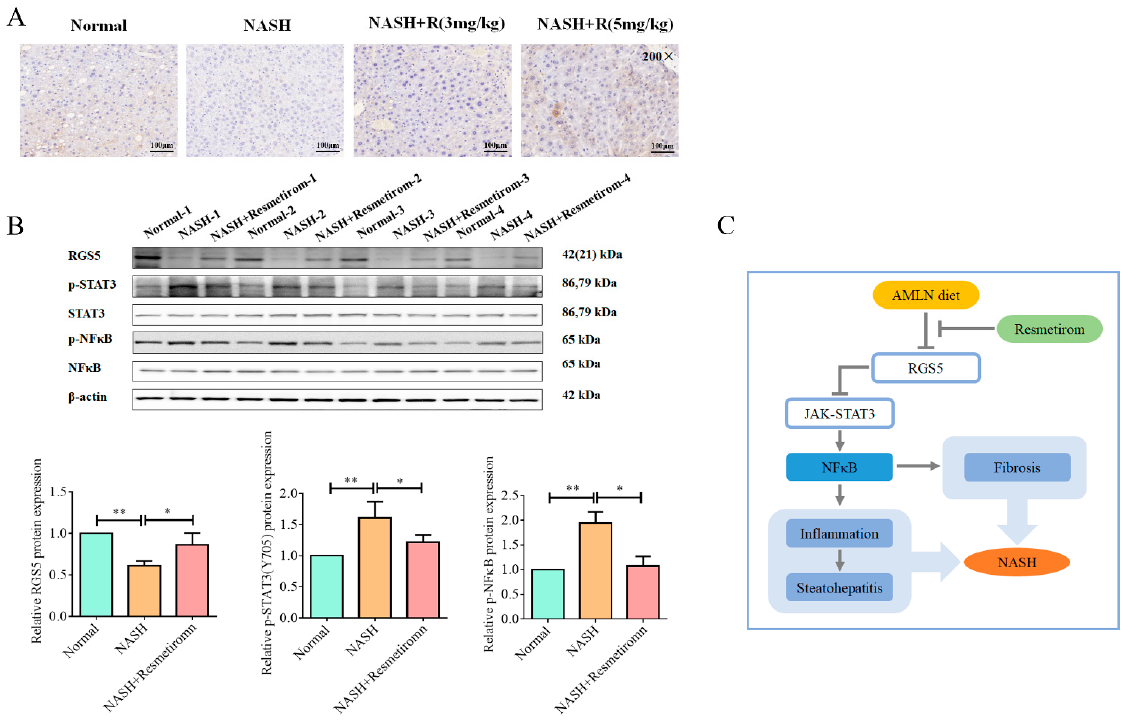
Figure 7. Resmetirom restored RGS5 expression and repressed the activation of STAT3 signaling pathway in NASH mouse model. ( A ), Sections of livers from mice in Figure 5 were used to perform the IHC assay to determine the RGS5 expression in liver tissue. Representative data are shown. ( B ), Total protein was extracted from livers in Figure 5, Western blot assay was performed to detect the expression of the indicated proteins. The protein level was analyzed and is presented in the histo- gram in the lower panel. ( C ), The potential underlying mechanism of how resmetirom improves NASH in a mouse model. Data are presented by mean ± SEM for three independent experiments. * p < 0.05; ** p < 0.01 vs. control.